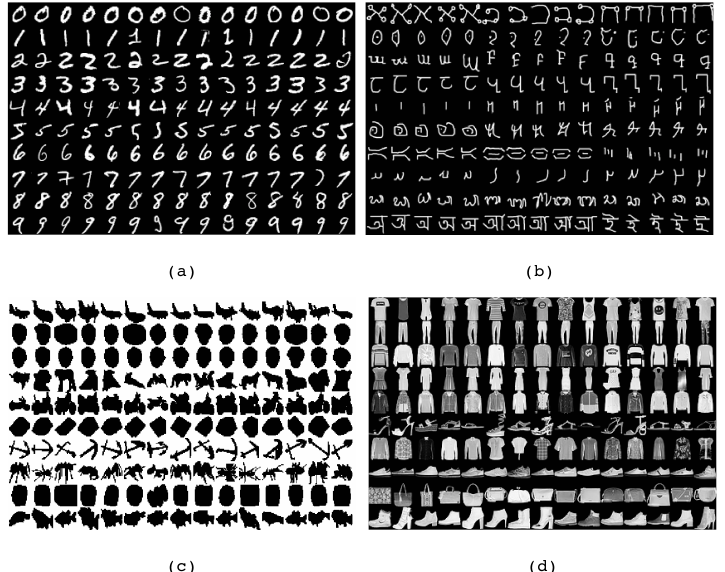
Figure 5. Random example images from the dataset; ( a ) MNIST, ( b ) Omniglot, ( c ) Caltech 101 Silhouettes, ( d ) Fashion